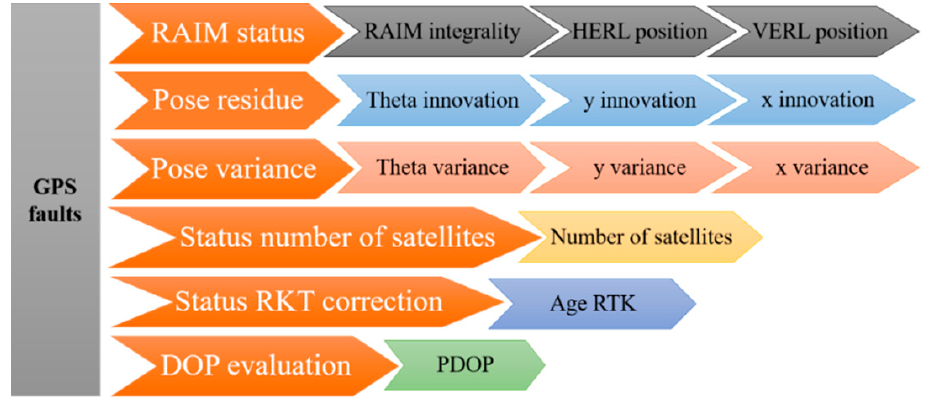
Figure 13. Global positioning system (GPS) diagnostic hybrid Bayesian network.